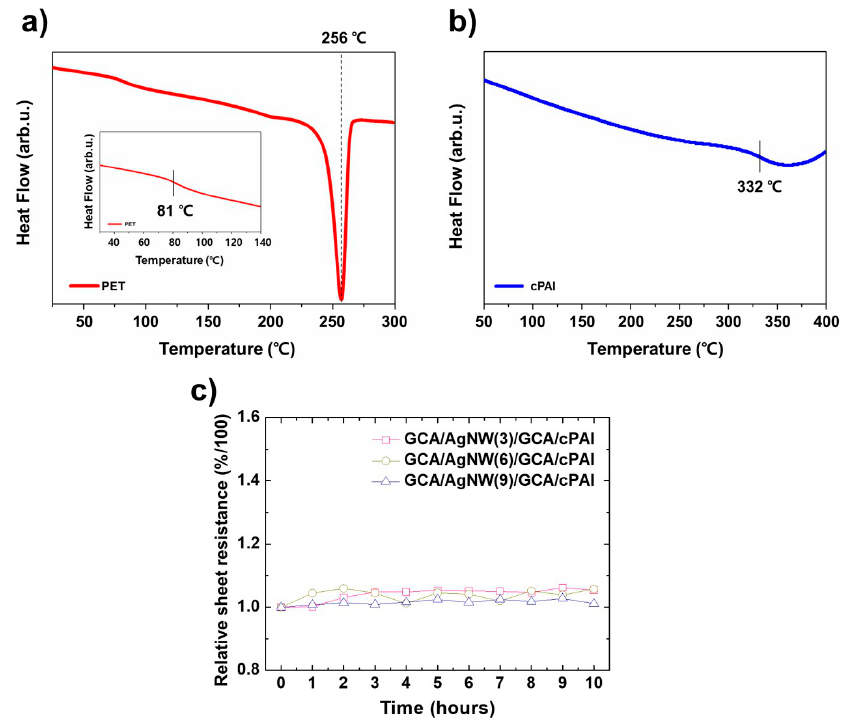
Figure 2. Glass transition temperature ( T g ) analysis of cPAI and PET using DSC: ( a ) PET, ( b ) cPAI. ( c ) High-temperature oxidation test of GCA/AgNW/GCA/cPAI electrode.